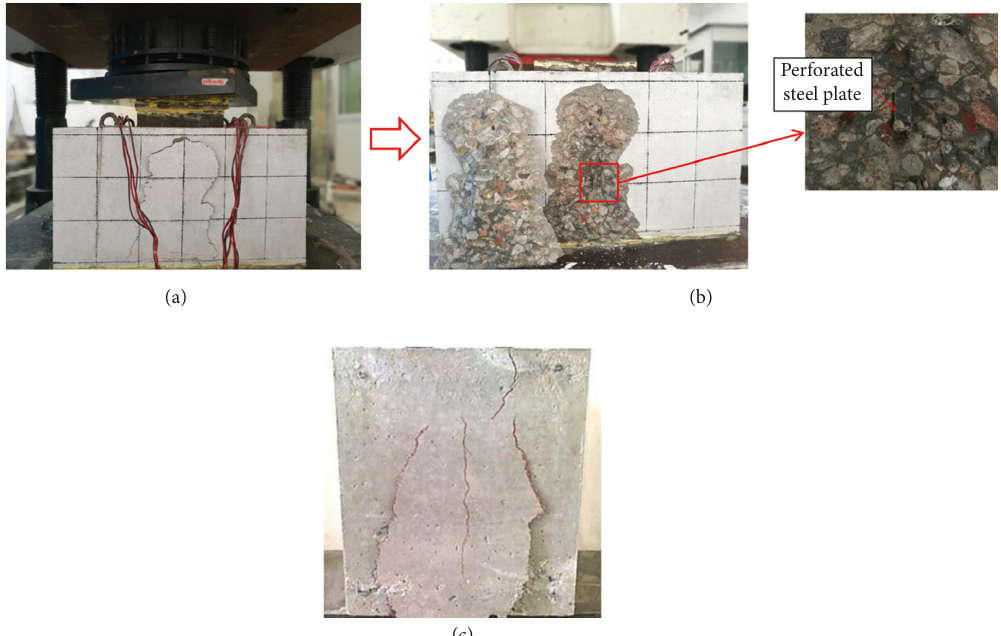
Figure 5: Crack distributions for push-out specimens (R-t10 example).